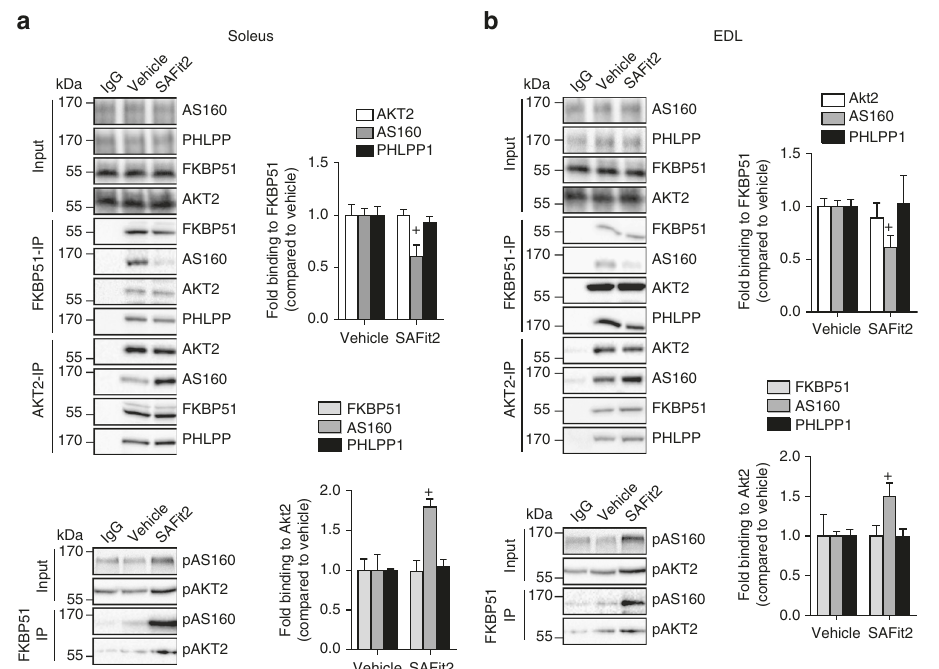
Fig. 6 FKBP51 antagonism affects AKT2-AS160 signaling complex. Tissue lysates from 30-day vehicle-treated or SAFit2-treated mice exposed to HFD were immunoprecipitated with anti-AKT2 and anti-FKBP51 and then analyzed by Western blot using FKBP51, (p)AKT2, (p)AS160, and PHLPP1. a , b Immunoprecipitation reactions revealed that SAFit2 treatment increased binding between (p)AKT2 and (p)AS160 in soleus ( a ) and EDL ( b ) muscles, while simultaneously decreased binding between FKBP51 and AS160 in both muscle types. For co-immunoprecipitation experiments n = 3 per group. Data are expressed as relative fold change compared to vehicle condition ± SEM. + P < 0.05, two-tailed t tests for a , b ; + signi fi cant SAFit2 treatment effect. Supplementary Fig. 15 shows uncropped gel